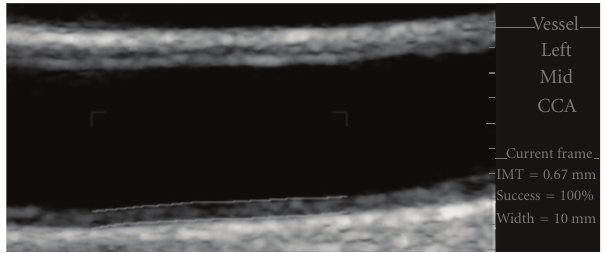
Figure 2: Carotid IMT. Automated edge detection software used to measure CIMT in the mid-common carotid artery (CCA). The CIMT was calculated at 0.67 mm in this